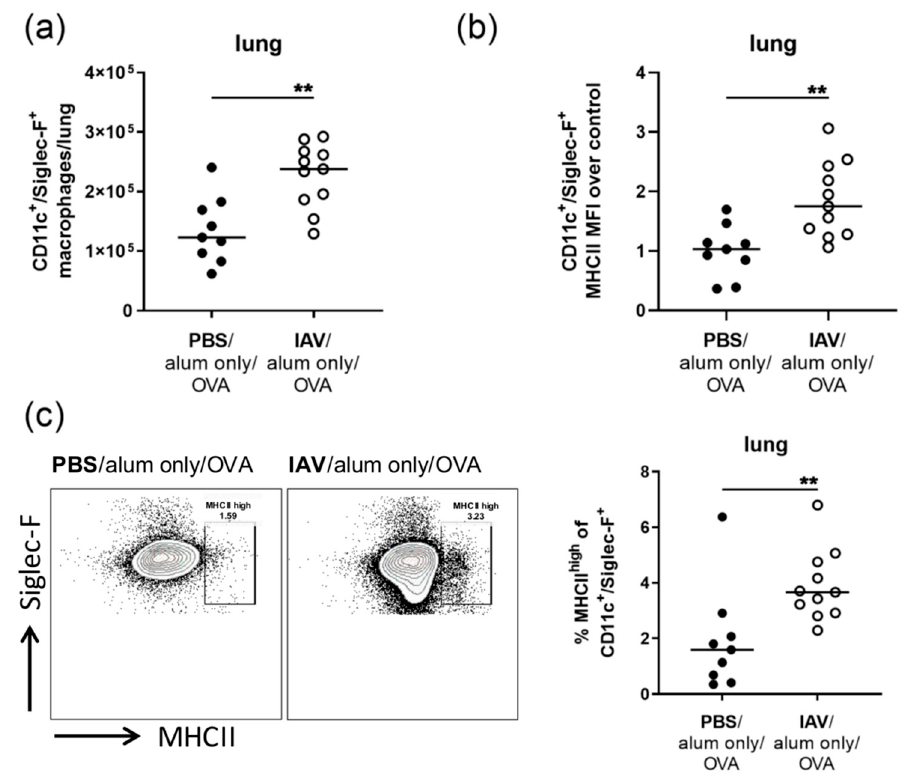
Figure 3. Resolved IAV infection leads to the accumulation of CD11c + / Siglec-F + macrophages with increased MHCII expression the lung. Mice were infected i.n. with a sublethal dose of IAV or treated with PBS on day 0, were mock-sensitized (alum only i.p.; days 14, 21, 28) and treated i.n. with OVA (days 35, 36, 37). On day 39 post infection, CD11c + / Siglec-F + macrophage numbers ( a ), CD11c + / Siglec-F + macrophage MHCII expression (MFI, median fluorescence intensity) ( b ) and the frequency of MHCII high CD11c + /Siglec-F + macrophages in the CD11c + /Siglec-F + macrophage population ( c ) were flow cytometrically analyzed. Data are shown for individual mice together with the group median. Representative flow cytometry plots show MHCII expression of the gated CD11c + / Siglec-F + macrophage population of an uninfected and an infected mouse. Data are compiled from three independent experiments. ** p < 0.01.